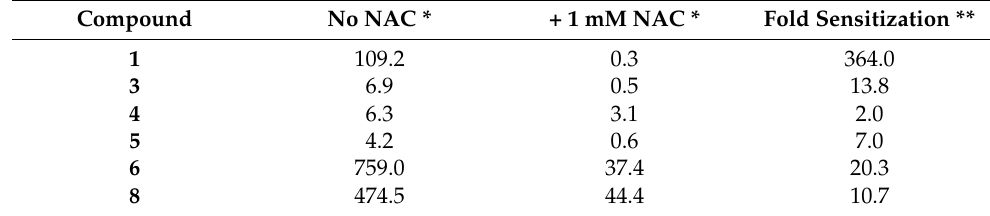
Table 2. Sensitization of HCT116 cells to Cu–organic compounds by